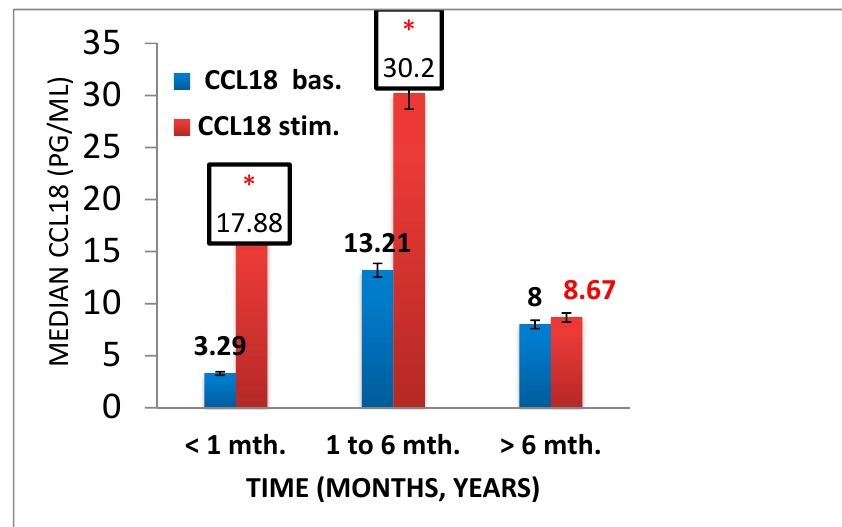
Figure 6. Anti-inflammatory activation chemokine CCL18 in patients with chronic foot ulcers ( n = 42) of various durations (< 1 to ≥ 6 months (mth.). There were 12 patients with less than 1 month of duration, 17 patients with 1 to less than 6 months of duration, and 13 patients with more than 6 months of ulcer duration . Bar histograms display median values, and whiskers reflect IQR (Q25; Q75). Significance level using the Kolmogorov–Smirnov test and Mann–Whitney test, * p < 0.05.